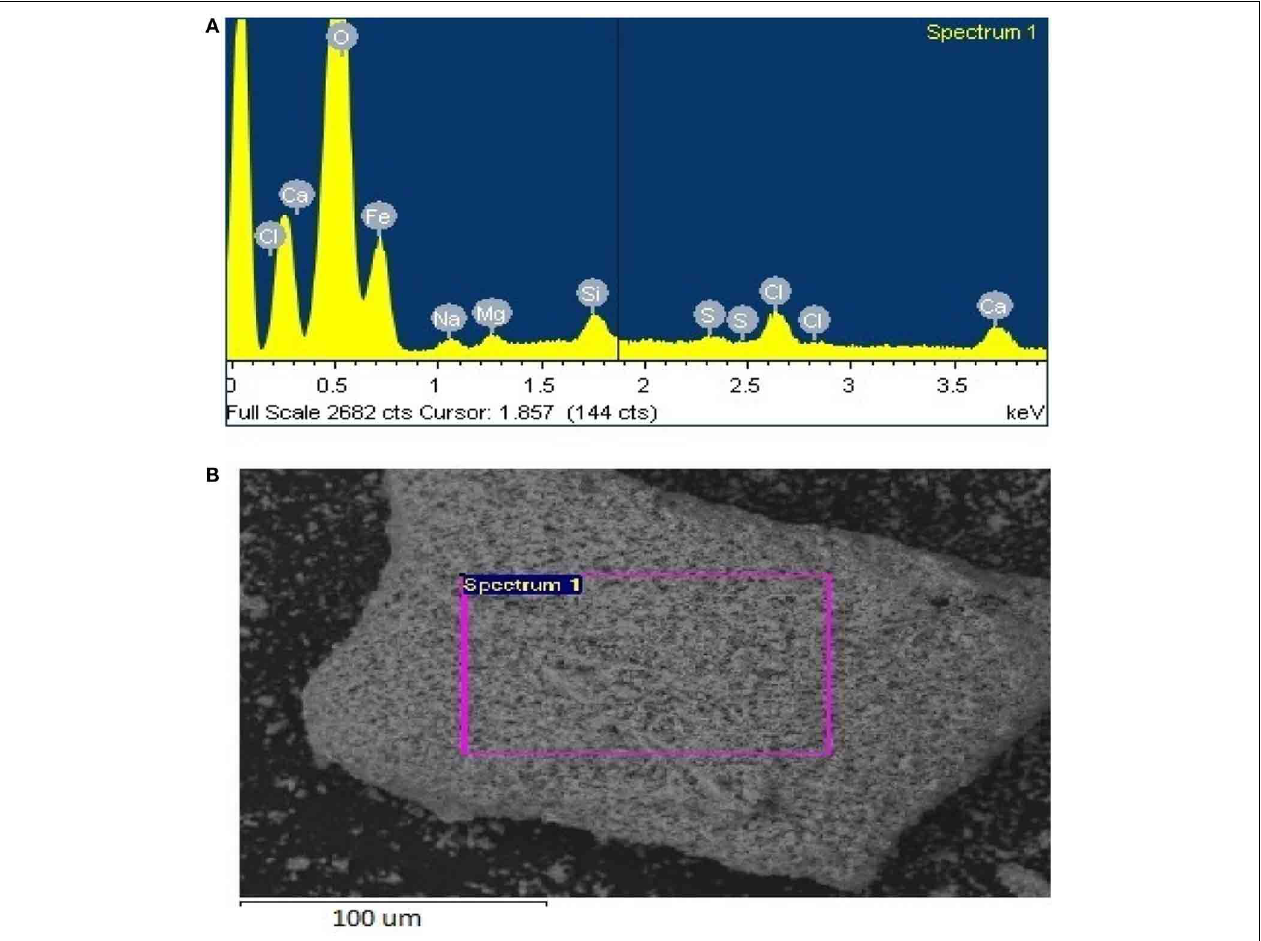
FIGURE 9 | (A) Site of observation for the samples from SD treatment (B) Elements obtained from spectrum one.